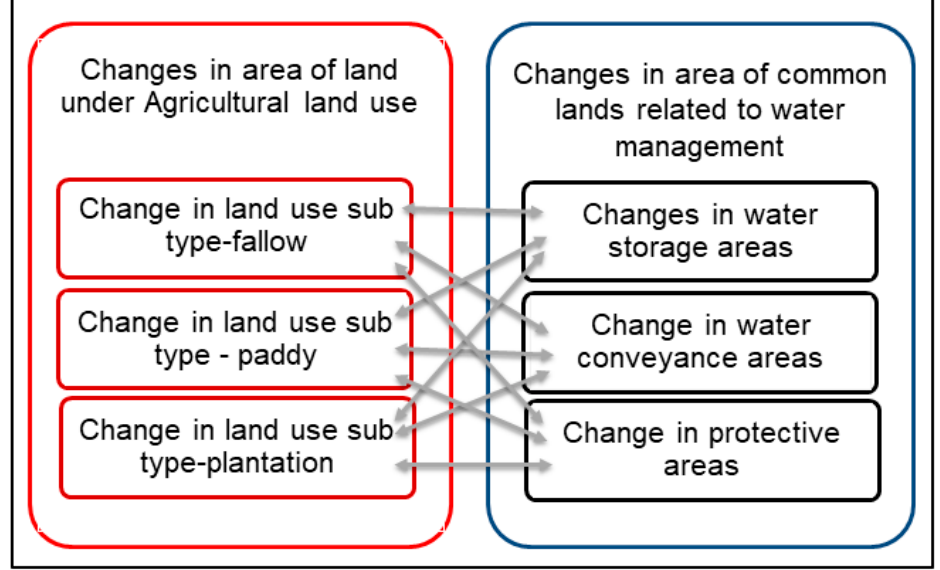
Figure 4. Components of analysis.